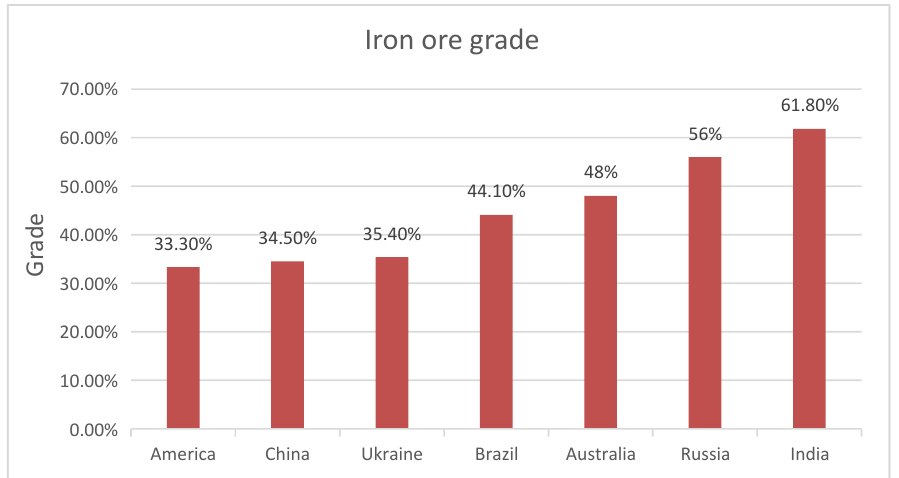
Figure 1. High and low iron ore grades by country.